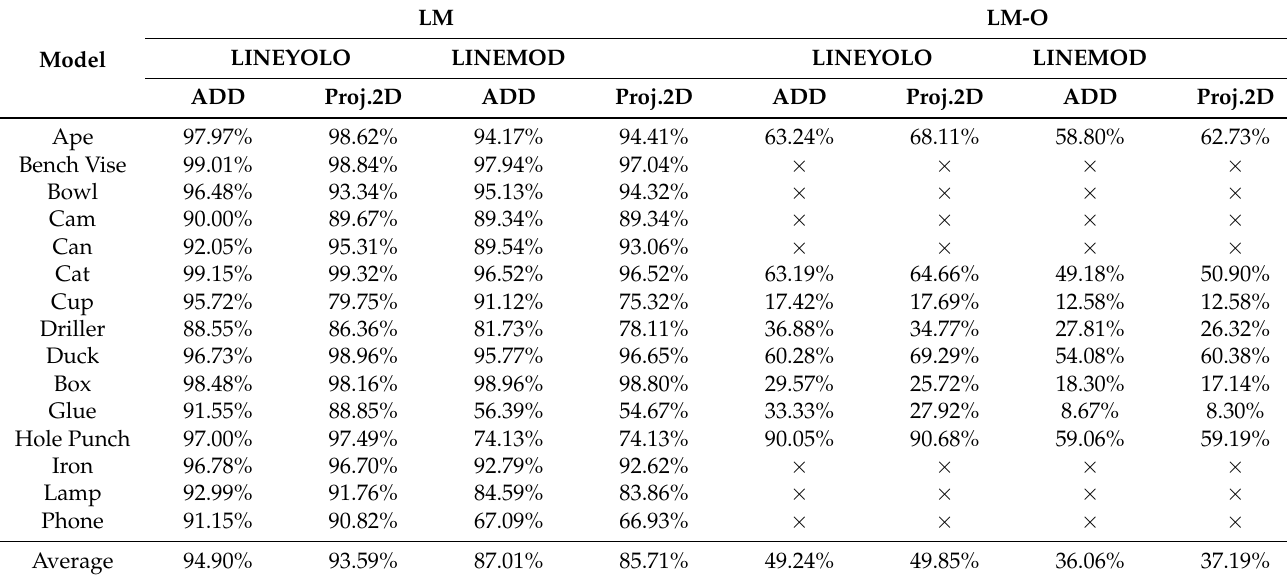
Table 4. Results of the LINEMOD-based pose detection and estimation system on the LM [15] and LM-O [59] data sets using different metrics with LINEYOLO or with LINEMOD. The percentage is calculated as the number of times the pose was correctly estimated with respect to the total number of images for each of the sequences.